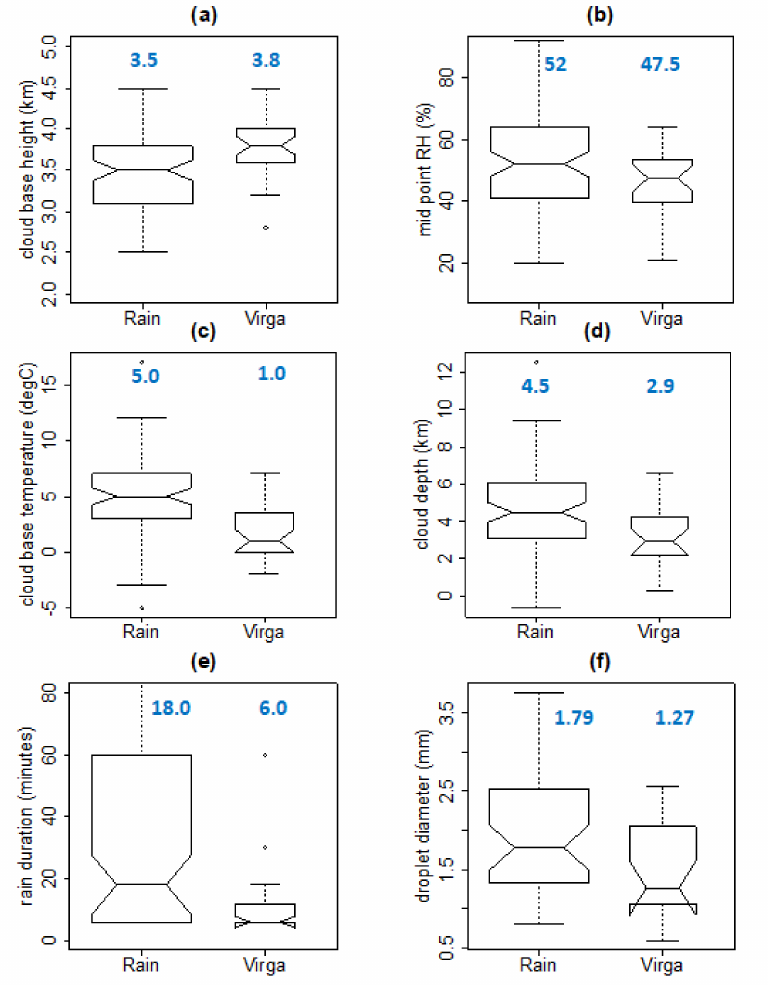
Figure 5. Cloud-related parameters divided into rainfall (77 events) and virga (28 events) at Al Ain, for ( a ) cloud base height, ( b ) relative humidity halfway between cloud base and surface, ( c ) cloud base temperature, ( d ) cloud depth, ( e ) rain duration, and ( f ) droplet diameter (box plots show the median and the interquartile range, with notches the confidence range on the medians; box width is proportional to number of cases). Median values are shown by the blue text at the top of each